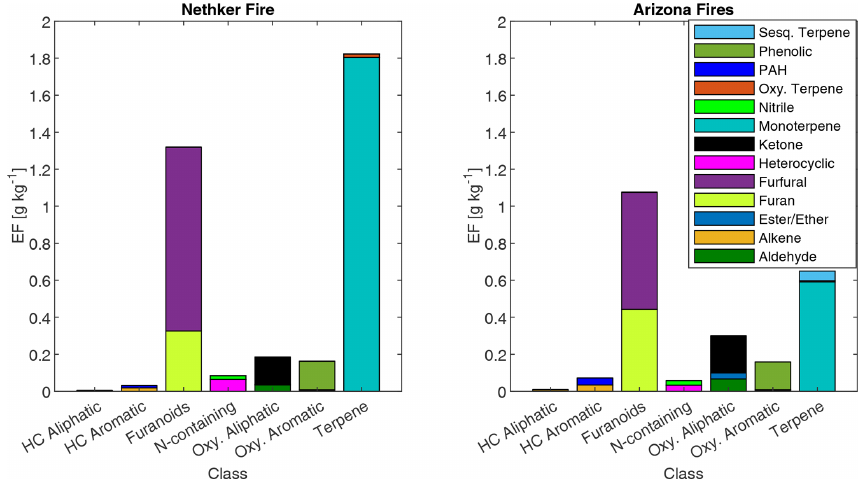
Figure 5. Emission factors of observed VOCs from the Nethker Fire ( N = 1) and Arizona Fires ( N = 2, averaged), grouped by chemical classification. HC refers to hydrocarbon.